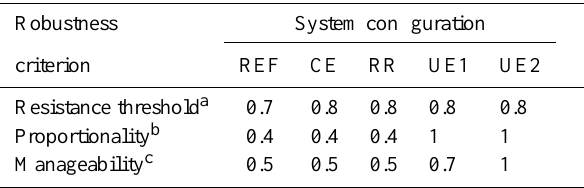
Table 2. Overview of scores on the robustness criteria. REF = Reference, CE = Conventional Embankment raising, RR = Room for the River, UE1 = Unbreachable Embankments version 1, UE2 = Unbreachable Embankments version 2. Robustness UE1